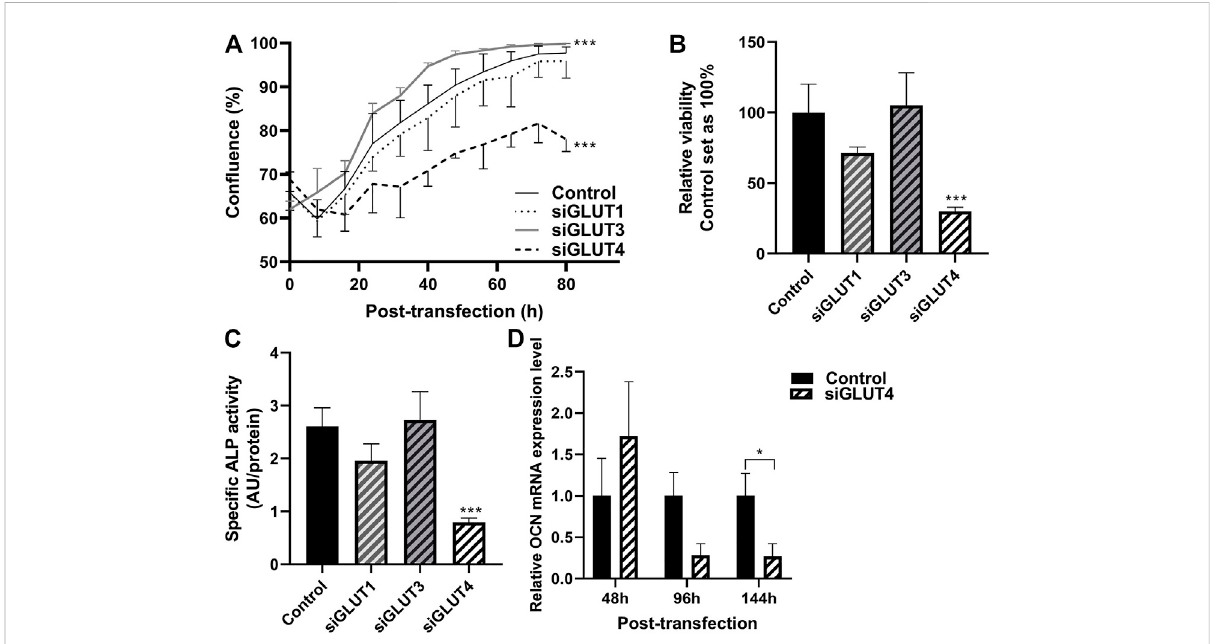
FIGURE 4 Silencing of GLUTs have different effects on proliferation and differentiation. Proliferation of silenced cells was studied by measuring cell con fl uence withusing theIncuCytereal-time imagingsystem. Aftertransfection,medium waschangedtoOM medium andcells wereimaged upto 92 h(80 hshown) (A) .Statisticalsigni fi canceswerecalculatedbycalculatingareaunderthecurveandcomparisonwasmadewithunpaired t -test.At the end point, viability of the cells was determined with alamarBlue – reagent (B) , differentiation was assessed with determining relative ALP activity to protein concentration (C) and relative osteocalcin expression compared to housekeeping gene (D) . Statistical difference was determined with Mann Whitney U or one-way ANOVA p values: * p < 0.05, *** p <